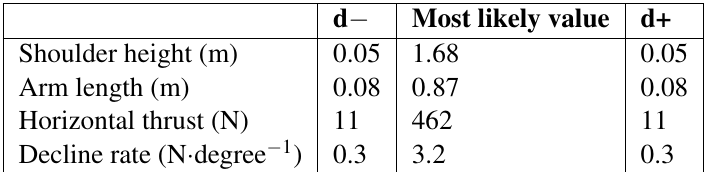
Table 3 List of membership functions.